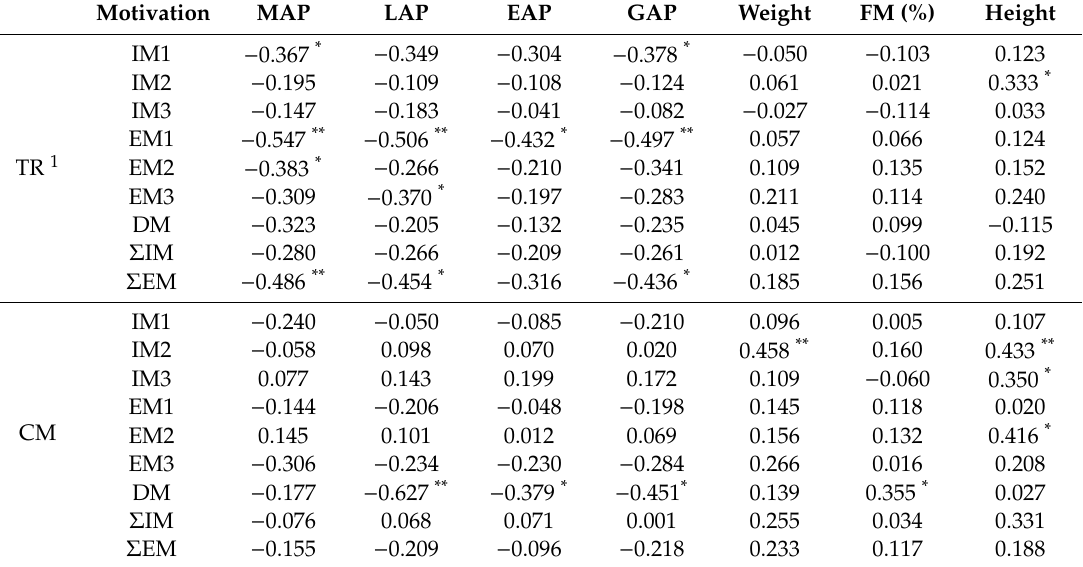
Table 3. Spearman’s rho and Pearson’s r tests between motivation and academic performance with physical